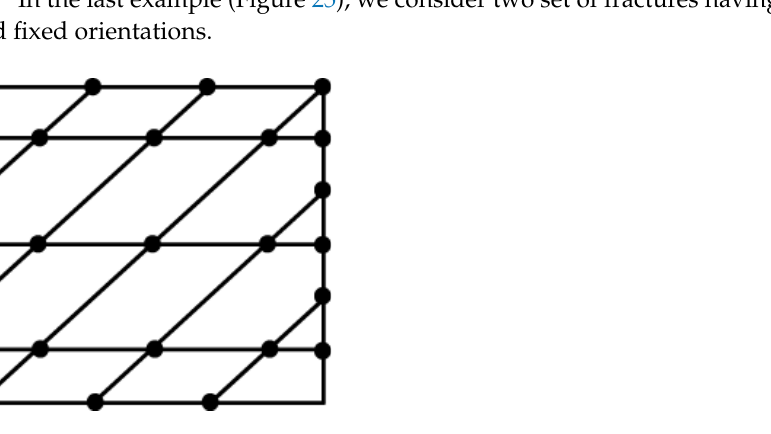
Figure 24. Schematic of a fracture network leading to a negative diagonal component for VSF. ( a ) Geometry of the network and Darcy velocities for the two upper edges of the network when a horizontal gradient is prescribed. ( b ) Geometrical representation of the sum of the two vectors represented in subplot ( a ).